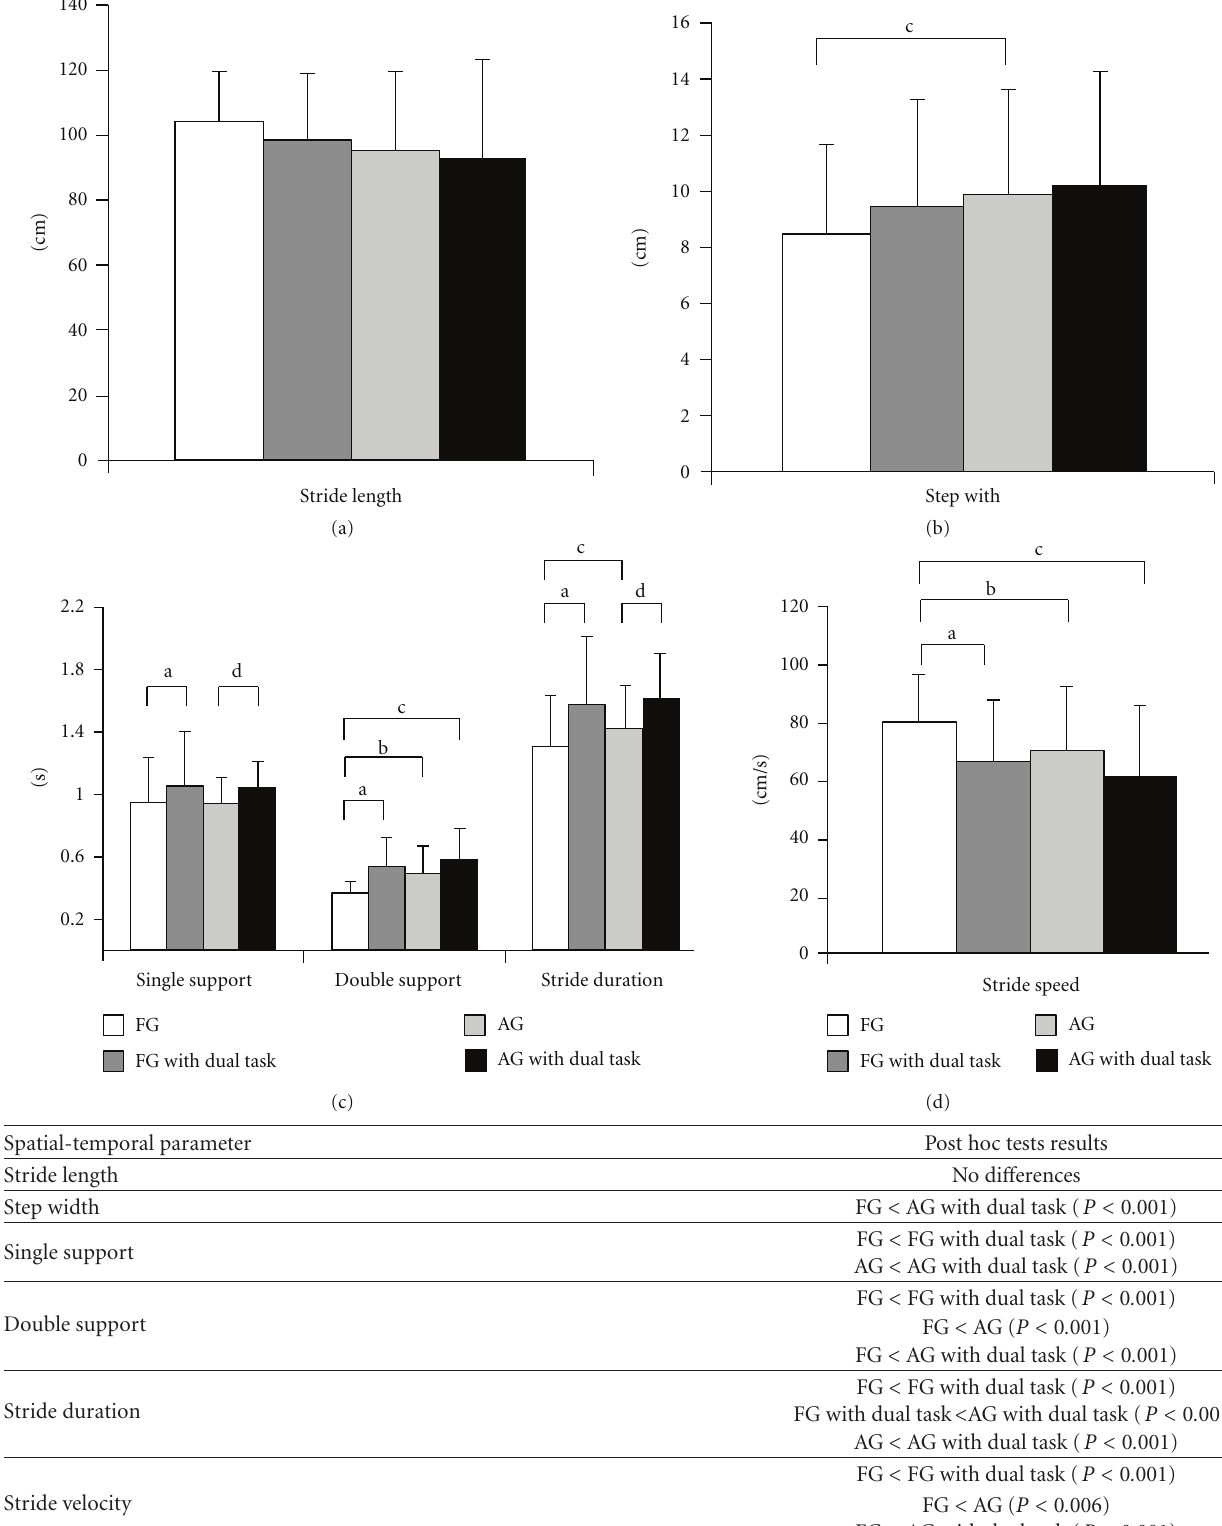
Figure 1: Mean and standard deviation of the spatial-temporal parameters for free and adaptive gait (approach phase). The table shows a summary of the significant di ff erence for the parameters. FG: free gait without dual task; AG: adaptive gait without dual task. In the figure, (a) di ff erences between free gait without dual task and free gait with dual task; (b) di ff erences between free gait without dual task and adaptive gait without dual task; (c) di ff erences between free gait without dual task and adaptive gait with dual task; (d) di ff erences between adaptive gait without dual task and adaptive gait with dual